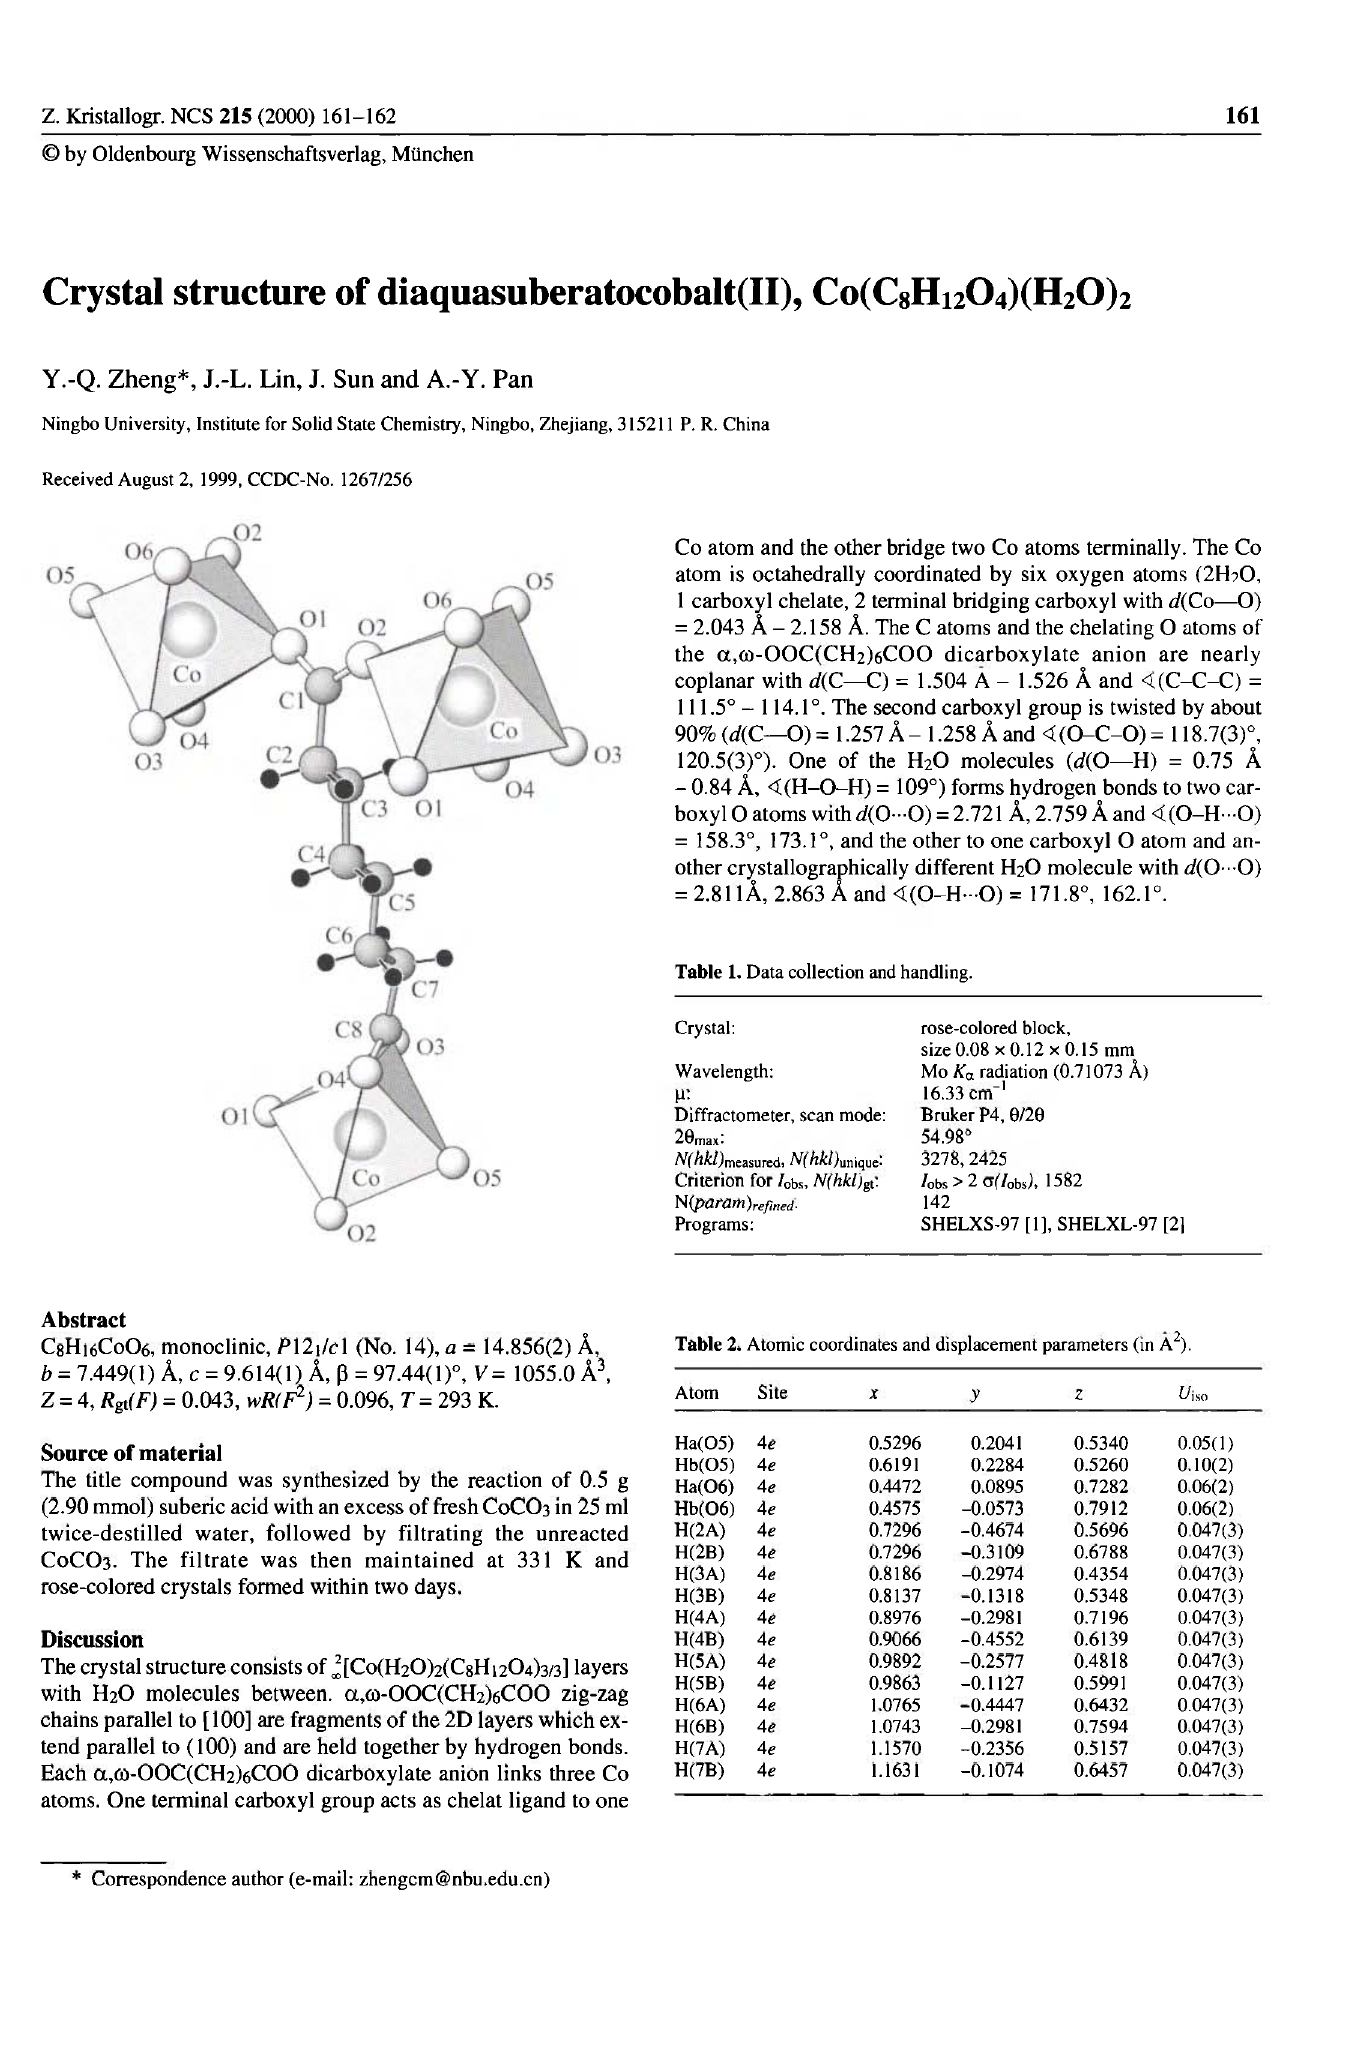
Table 2. Atomic coordinates and displacement parameters (in A 2